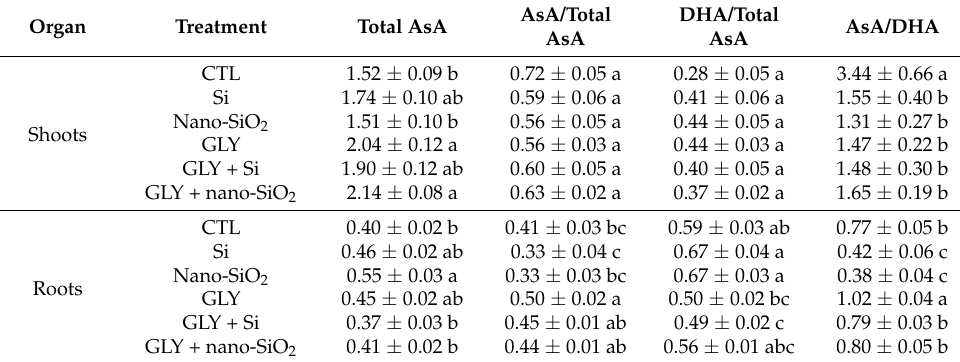
Table 2. Levels of total AsA ( µ mol g − 1 fm), along with its reduced and oxidized forms (dehydroascorbate—DHA), of S. lycopersicum plants after 4 weeks of growth. Data presented are mean ± STDEV ( n ≥ 3). Different letters (a–c) indicate significant statistical differences between treatments (Tukey: p ≤ 0.05).